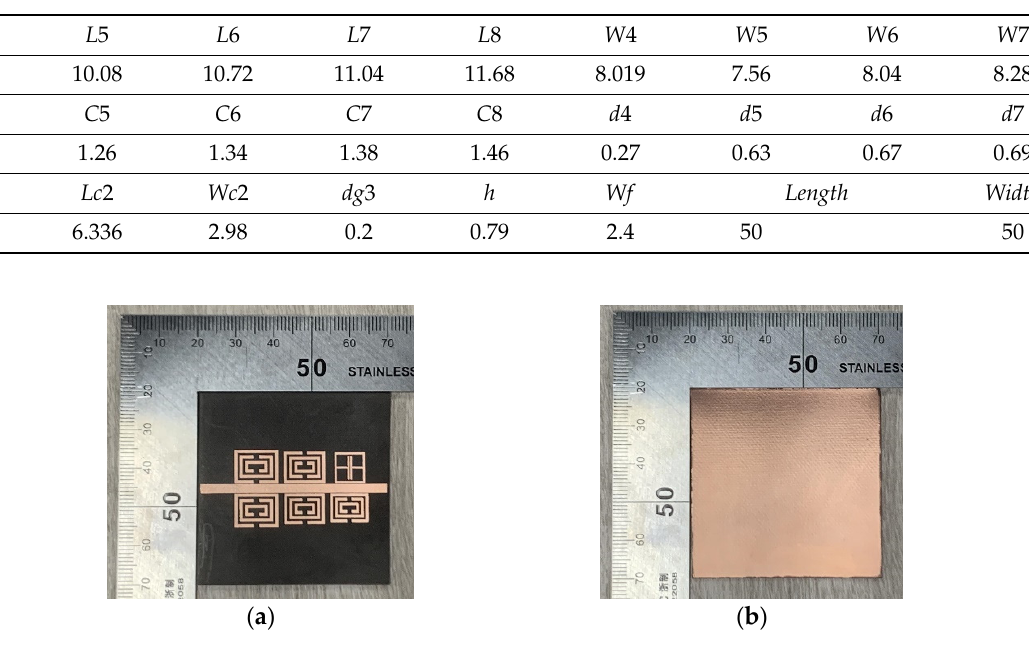
Figure 8. The 6-bit chipless tag object: ( a ) Tag radiation surface; ( b ) Tag ground surface.